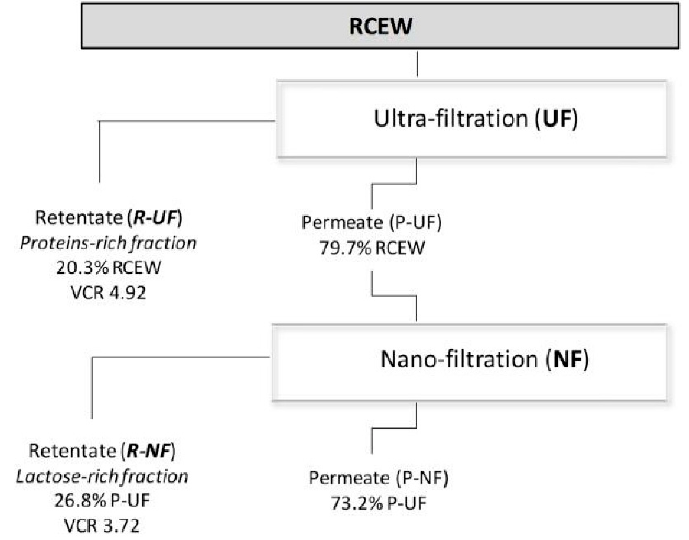
Figure 1. Flow-chart of fractionation process. RCEW ricotta cheese exhausted whey, R-UF and P-UF retentate and permeate after ultra-filtration (UF), R-NF and P-NF retentate and permeate after nano-filtration (NF). Fraction recover (expressed as % v / v ) and Volume Concentration Ratio (VCR) were also reported.